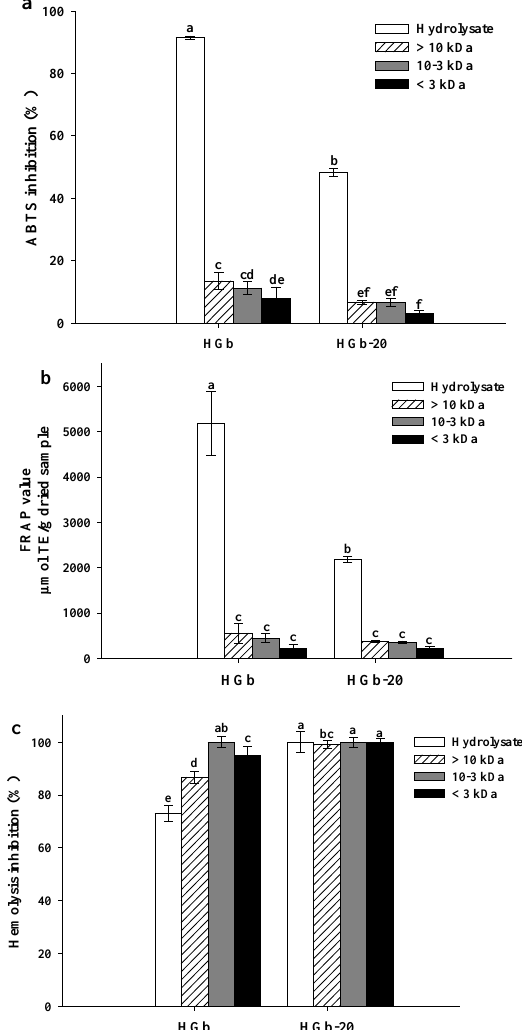
Figure 2. Antioxidant activity of globulin hydrolysates and peptide fractions. ( a ) ABTS assay; ( b ) FRAP assay; ( c ) Hemolysis inhibition assay. Results are plotted as mean ± standard deviation of triplicate determinations. Bars with different letters are significantly different ( p < 0.05). Concentra- tions of hydrolysates and peptide fractions were 200 µg/mL. HGb = Hydrolysate of globulin at with- out pulses and HGb - 20 Hydrolysate of globulin at 20 min of ultrasound pretreatment. For the protective effect in the erythrocytes assay (Figure 2c), favorable results were found. Peptide fractions obtained from HGb showed hemolysis inhibitions ranging from 86.68 to 100%, significantly greater than that of hydrolysate (73.04%). Low - molecular - weight peptides, being a short chain of amino acid residues, have smaller steric hindrance compared to hydrolysates, allowing the interaction between hydrophobic and hydro- philic amino acids with free radicals, neutralizing them [51]. The peptide fractions of HGb - 20 maintained the ability to inhibit hemolysis, with values from 99 to 100%. Pulsed ultra- sound pretreatment favored the obtaining of peptide fractions with hydrophobic amino acids, which facilitated the interaction between peptide fractions and erythrocyte mem- branes [18]. The peptide fractions obtained from the hydrolysates HGb and HGb - 20 showed an antioxidant capacity in which the mechanism of action was HAT, a mechanism measured by the performed assay [45]. 3.5. Electrophoretic Profiles Figure 3a shows the electrophoretic profile of chickpea proteins and hydrolysates ob- tained in this research. Different electrophoretic profiles were observed for albumin, glob- ulin and glutelin concentrates (Figure 3a; lines B, C, and D). For albumin, bands with mo- lecular weights from 97 to 21 kDa were observed, with three main bands with molecular weights of approximately 97, 48 and 40 kDa (Figure 3a, lane B). Papalamprou, Doxastakis,